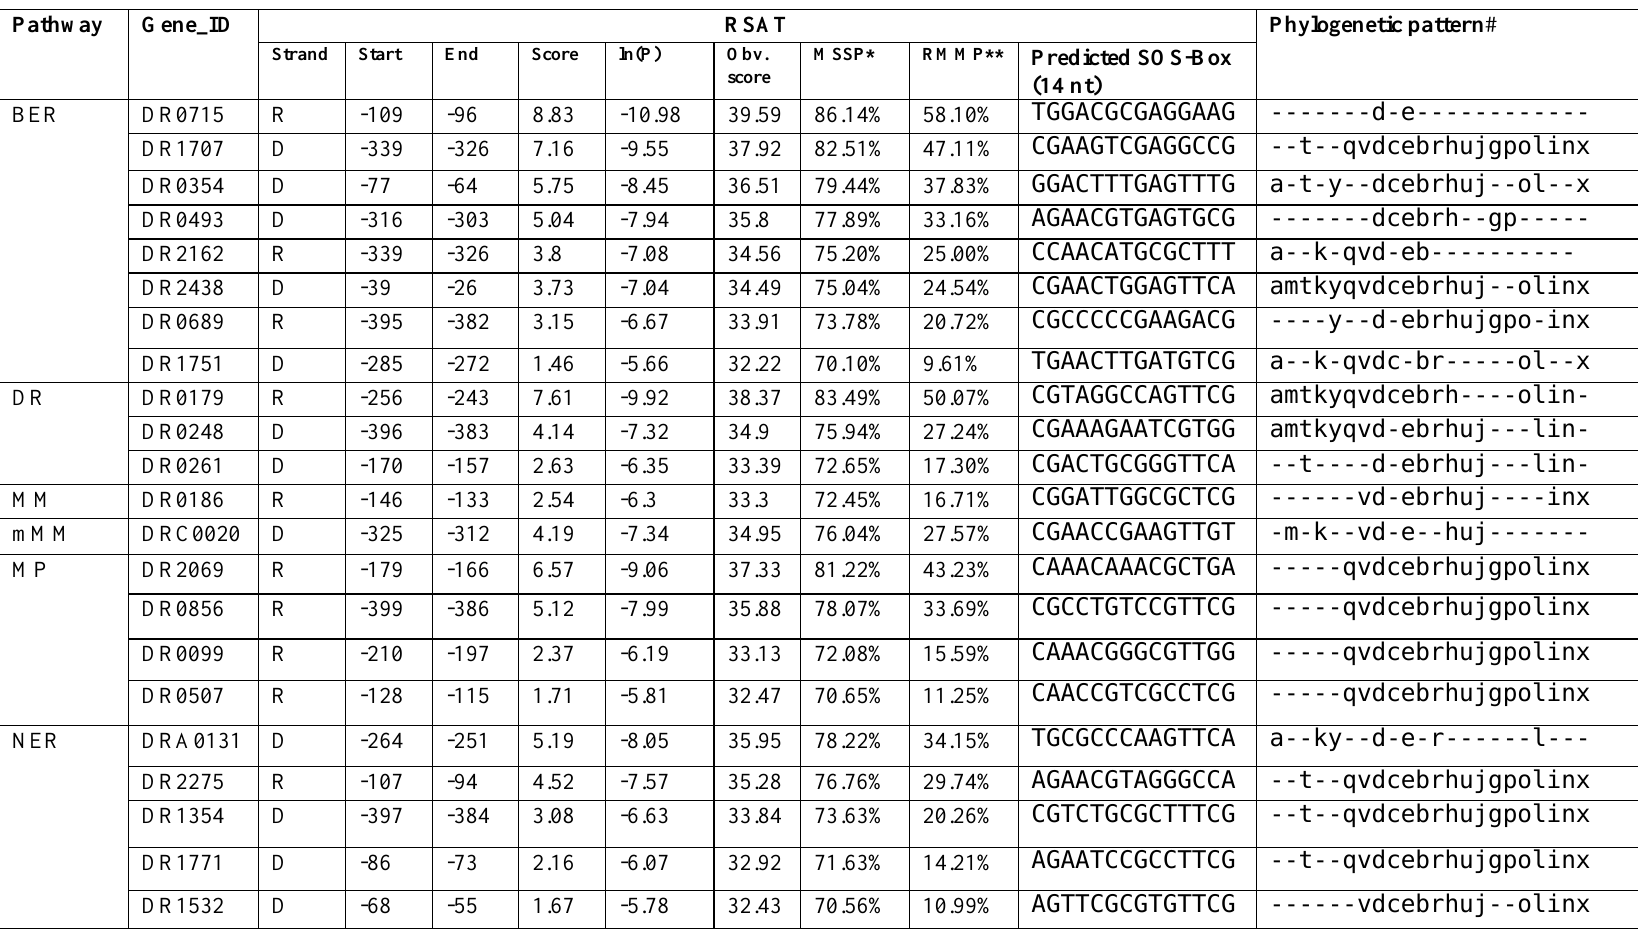
Supplementary Table 5 (S5): Details of SOS-box motifs predicted in the upstream sequences of D. radiodurans genes related to replication, repair and recombination functions through RSAT